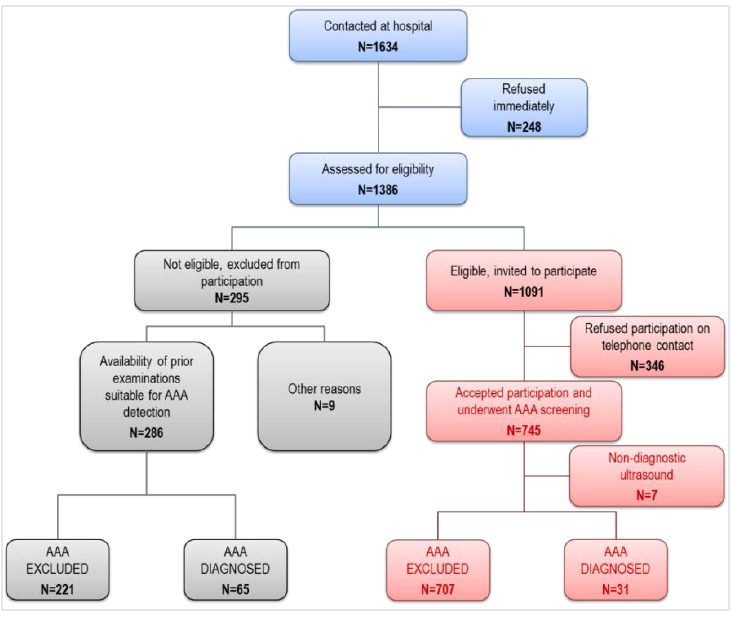
Figure 1: Study eligibility and recruitment. AAA = Abdominal aortic